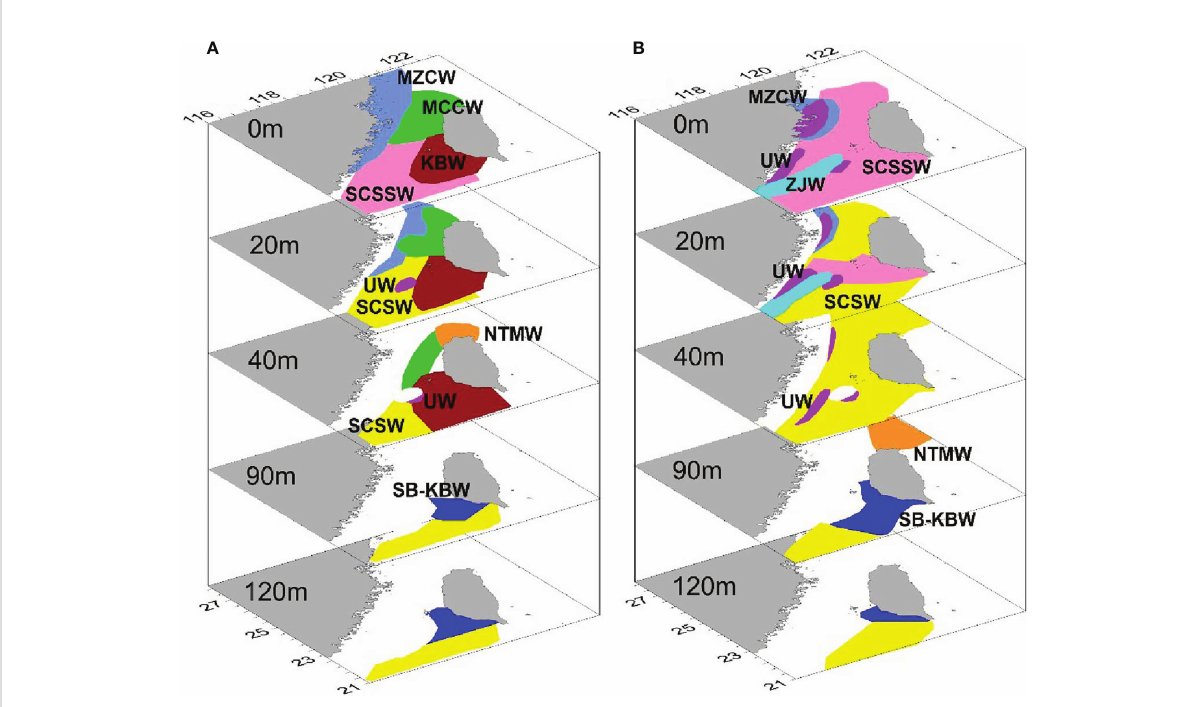
FIGURE 3 Water mass distribution in the Taiwan Strait in (A) winter and (B) summer. Light blue- MZCW , Green- MCCW , Violet- UW , Orange- NTMW , Pink- SCSSW , Yellow- SCSW , Dark Red- KBW , Blue- SB-KBW , Bright blue- ZJW . (Redrawn and integrated from: Weng et al., 1992; Xiao et al., 2002; Hu